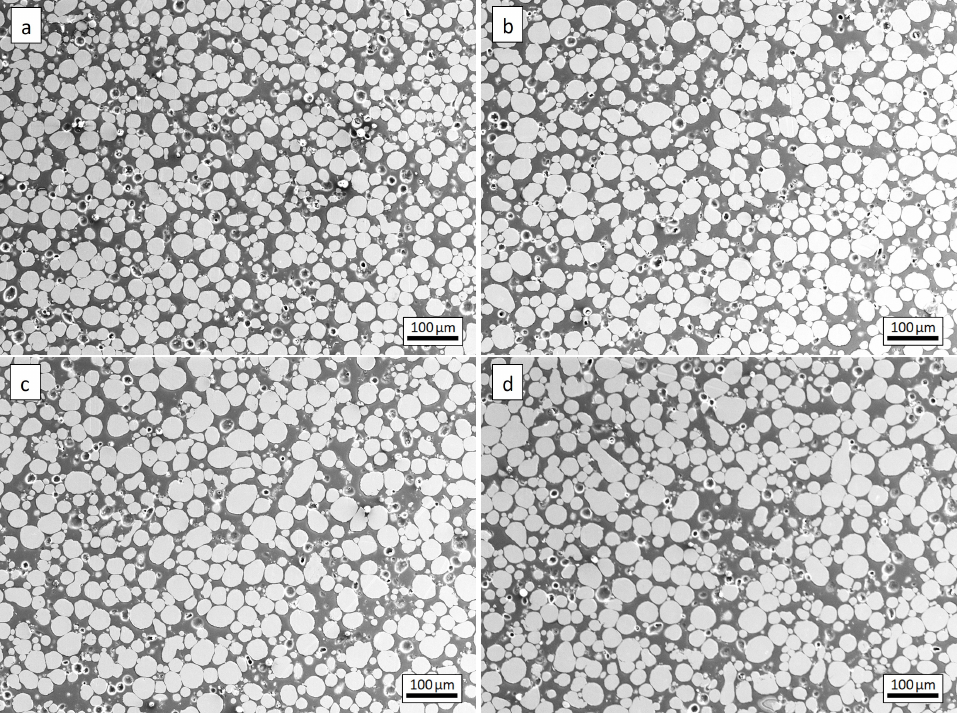
Figure 5. Microstructure of green body compacted under G = 1800 at radial positions of